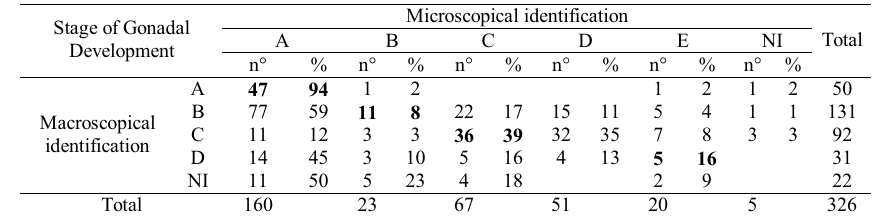
Table 2. Merluccius hubbsi: comparison between macroscopical and microscopical staging of ovarian development. Abso- lute values and percentages related to macroscopical identifications for agreement identifications are in bold